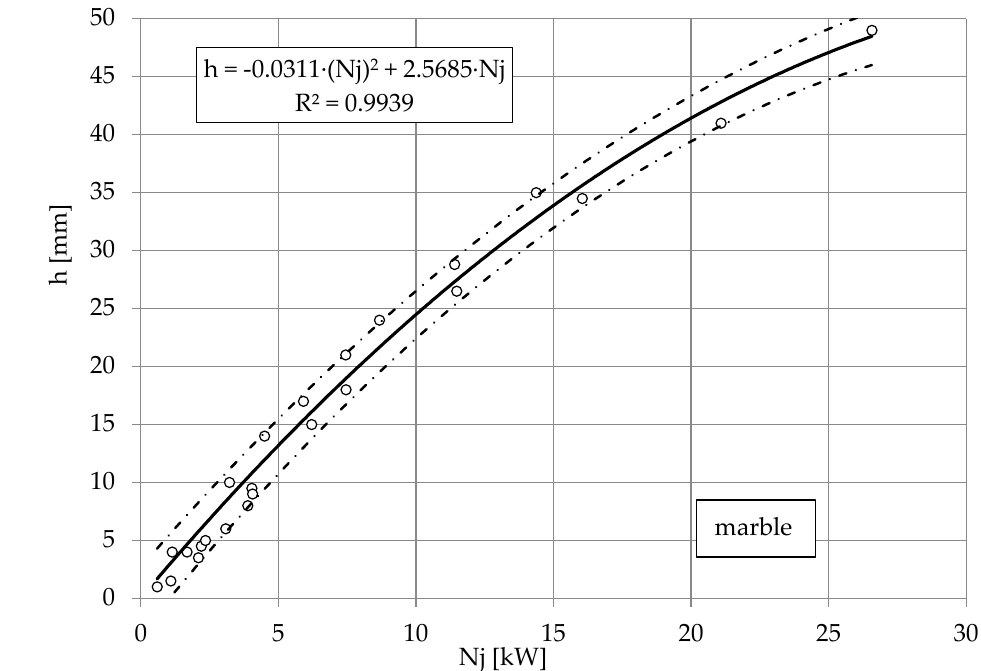
Figure 10. Influence of jet power Nj on cutting depth h of marble, with abrasive waterjet: feed speed v p = 3 mm · s − 1 , abrasive flow rate m a = 6.7 g · s − 1 .